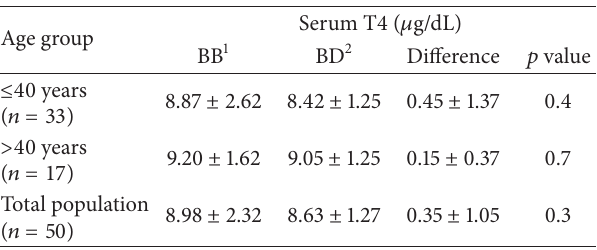
Table 3: Changes to the serum levels of T4 during the study (all data are reported as mean ±